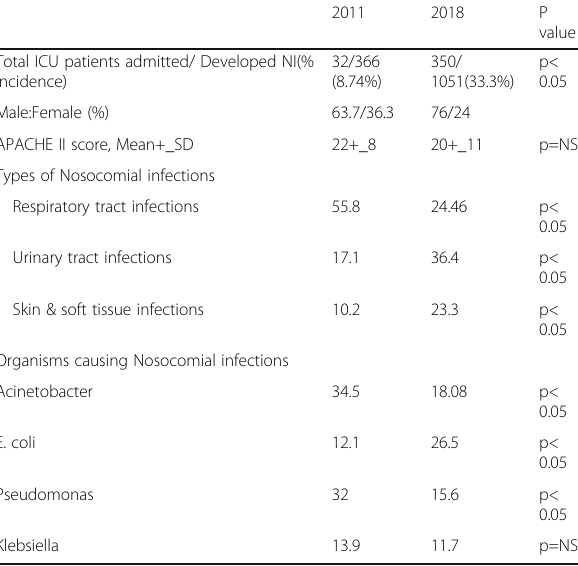
Table 1 (abstract 001645). See text for